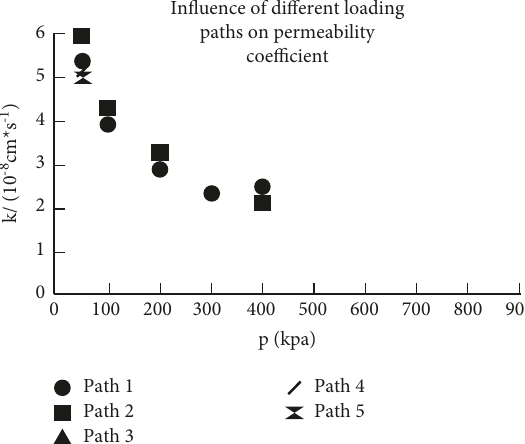
Figure 3: Relationship between permeability coefficient and consolidation pressure under different consolidation